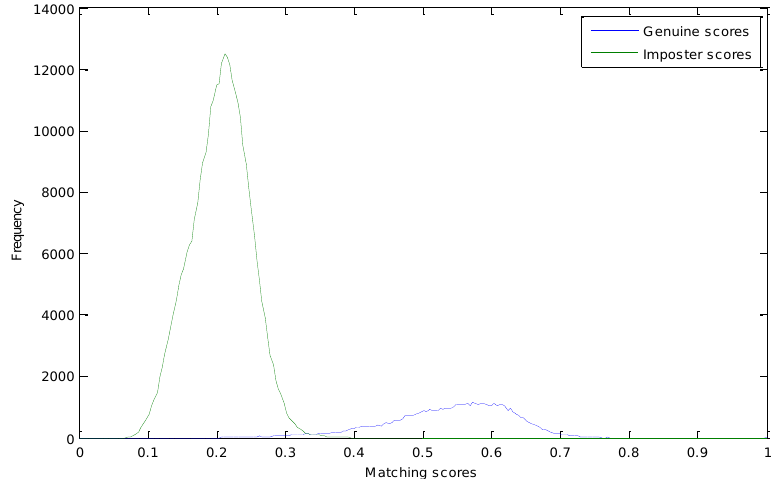
Figure 7. Matching score distribution of the LDC -00-based finger vein recognition.